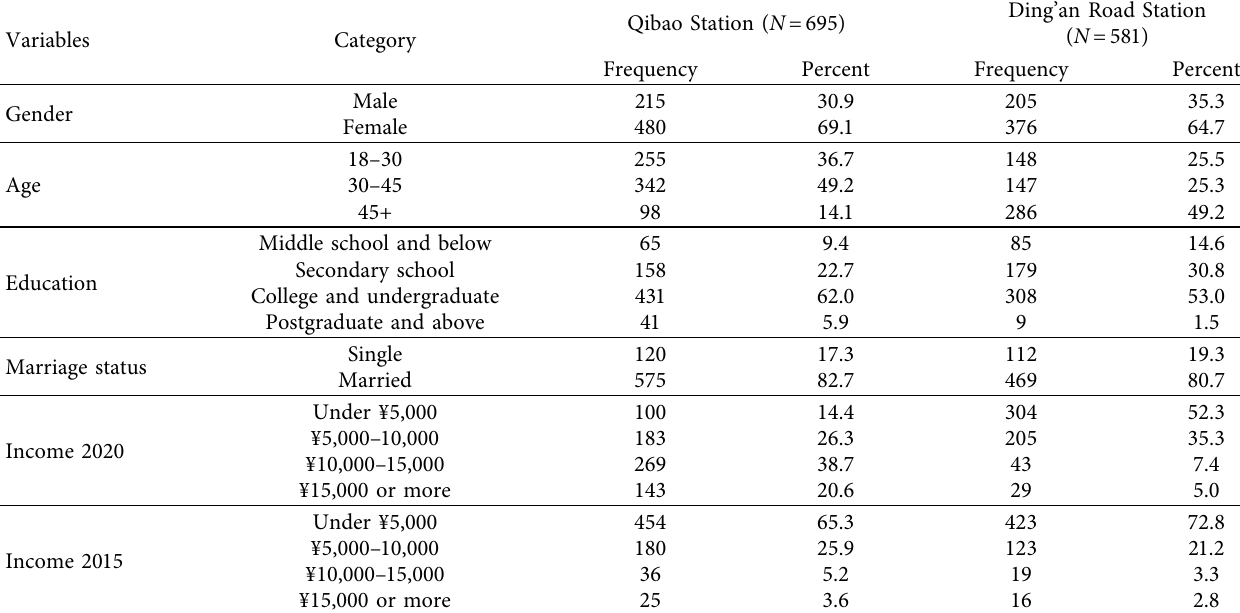
Table 2: Demographic characteristics of the